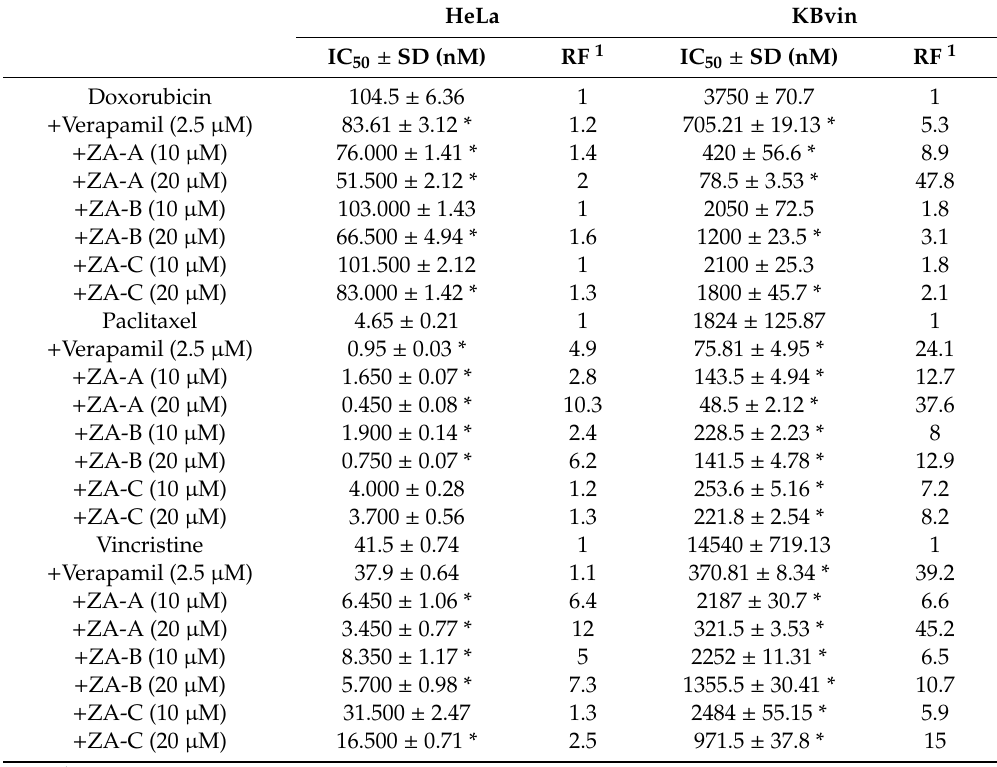
Table 1. The cytotoxic IC 50 and reversal fold of drug resistance for ZAs A, B, C in combination with chemotherapeutic drugs in HeLaS3 and MDR KBvin